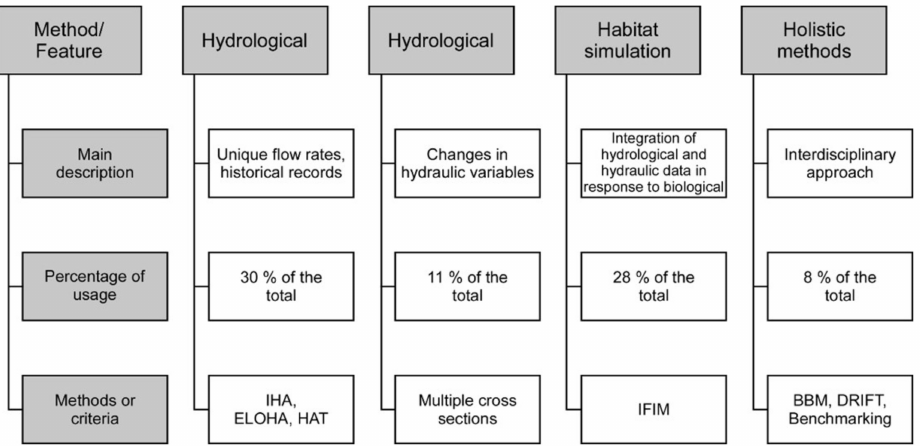
Figure 1. Classification of methodologies to determine environmental flow. From the methods or criteria: IHA = Indicators of Hydrological Alteration, ELOHA = Ecological Limits of Hydrological Al- teration, HAT = Hydrological Assessment Tool, IFIM = Instream Flow Incremental Methodology, BBM = Building Block Methodology, DRIFT = Downstream Response to Imposed Flow